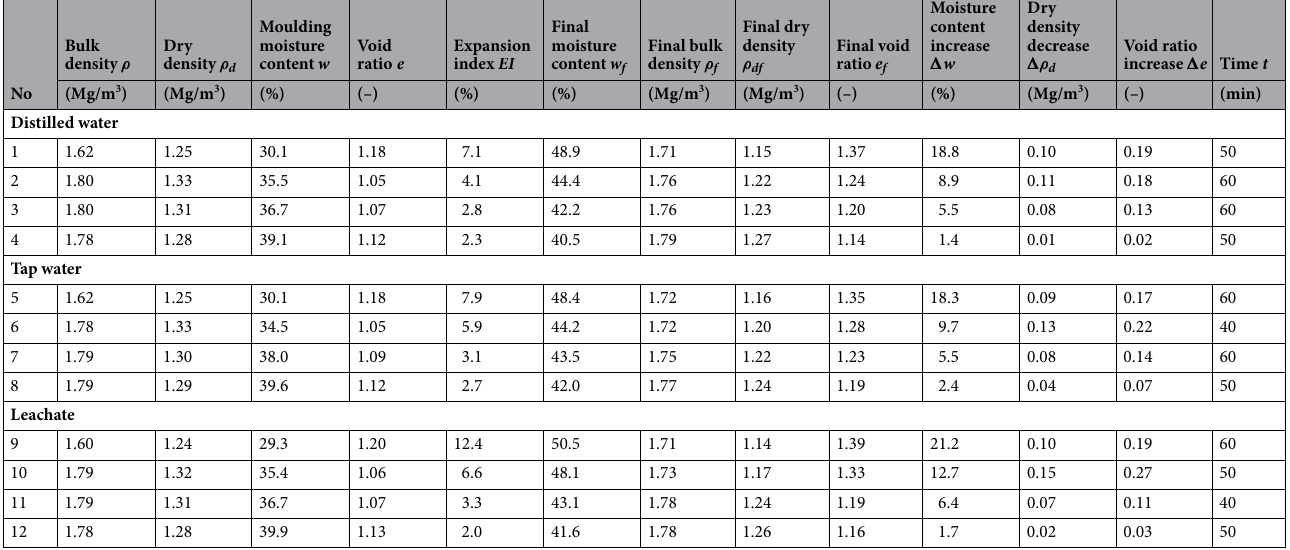
Table 4. Swell test